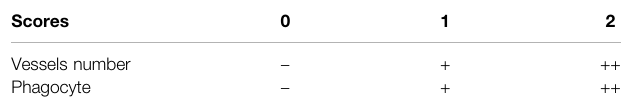
TABLE 3 | Semi-quantitative repair score